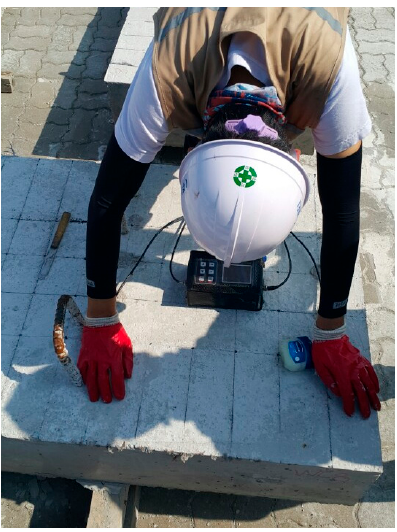
Figure 9. P-wave measurement in a grid on the surface of a concrete wide beam.